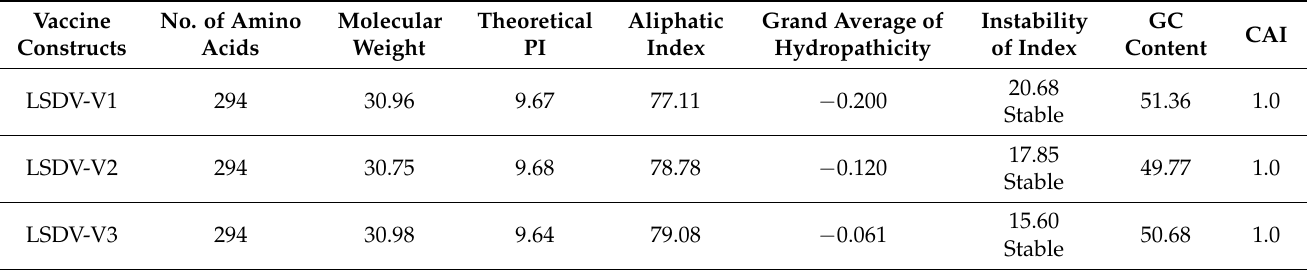
Table 4. Physiochemical properties of multi-epitope mRNA vaccine constructs.